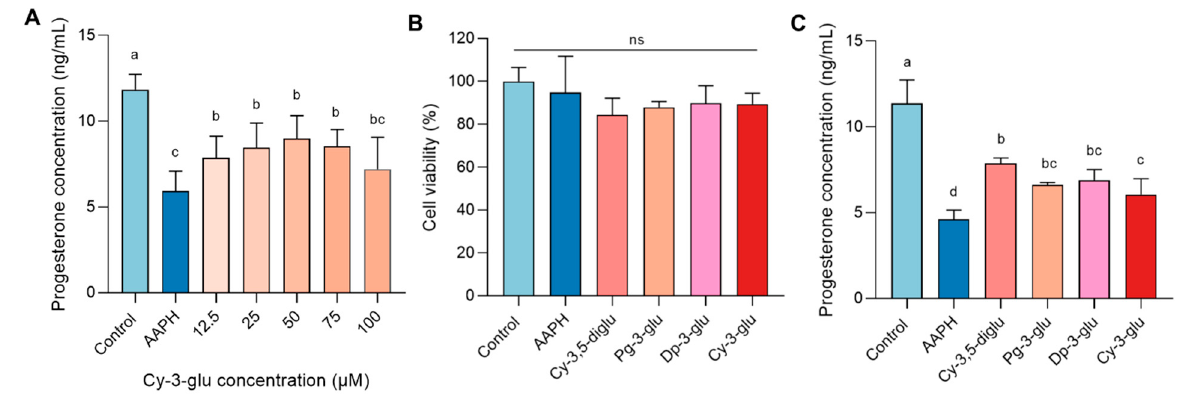
Figure 3. Anthocyanins ameliorate progesterone secretion in AAPH-damaged R2C cells: ( A ) Recovery of progesterone synthesis by different concentrations of Cy-3-glu, n = 6. ( B ) Effect of four anthocyanins on the viability of R2C cells, n = 5. ( C ) The change in AAPH-induced reduction in progesterone synthesis by 50 μ M of four anthocyanins, n = 4. All data were analyzed for differences by one-way ANOVA. Different letters indicated that there is a significant difference ( p < 0.05).